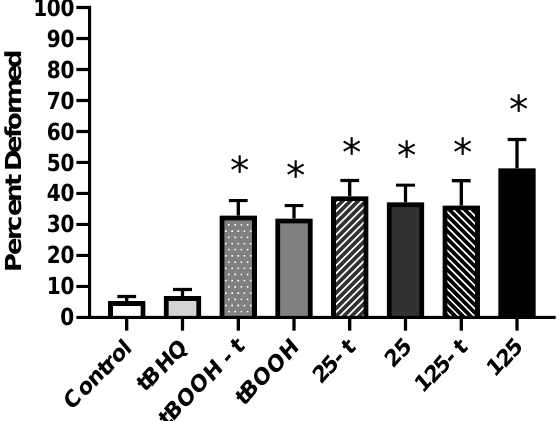
Figure 6. Mean ( ± SE) percentage of total deformities (sum of skeletal, craniofacial, finfold, and edema) in larval zebrafish exposed via embryo aqueous exposure to facility water (control), tBHQ, tBOOH, and two concentrations of SeMet (25 and 125 µ g Se / L) either with (tBOOH-t, 25-t, 125-t) or without (tBOOH, 25, 125) a tBHQ pre-treatment. Asterisks represent significant di ff erences from control using a Kruskal–Wallis one-way analysis of variance (ANOVA) by ranks followed by a Dunn’s multiple comparisons test ( p < 0.05); n = 13–33 replicates of 20 embryos. The incidence of kyphosis increased significantly within all SeMet treatment groups ( p ≤ 0.045), with percentages of 7.36% ± 2.9%, 8.62% ± 3.3%, 12.8% ± 5.2%, and 25.6% ± 9.3% in the 25-t,